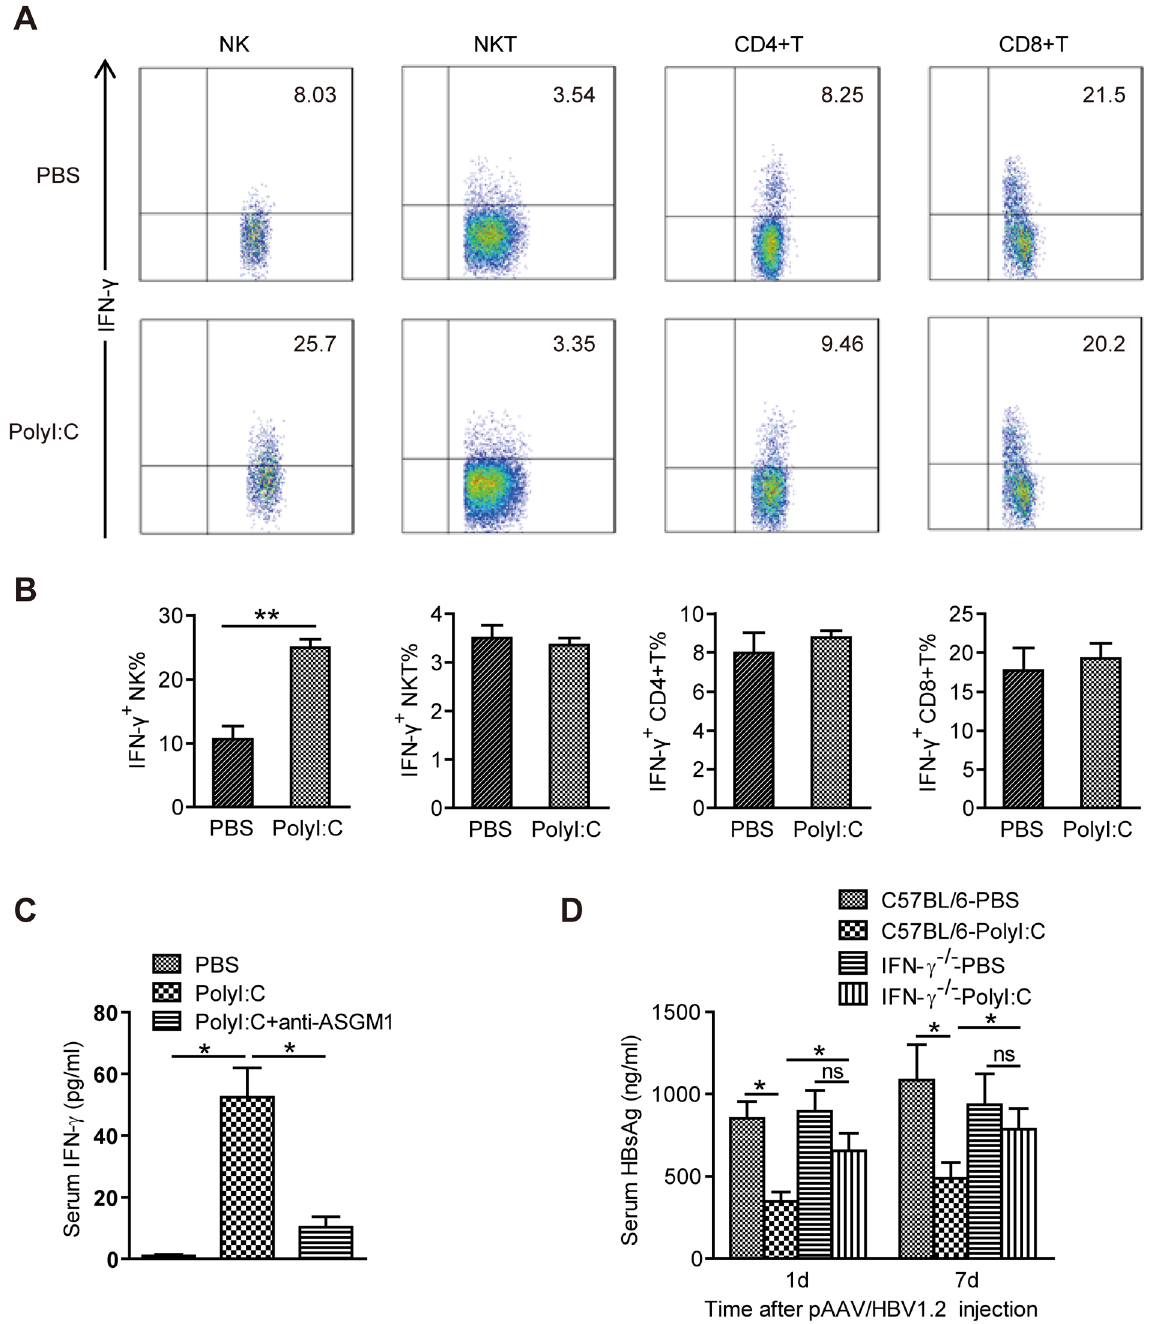
Figure 6. Anti-HBV activity of PolyI:C is dependent on NK cell-derived IFN- γβ . ( A , B ) C57BL/6 mice were injected with HBV plasmid and chronically treated with Poly I:C as described in Materials and Methods. Intracellular cytokine staining was performed to examine IFN- γ production from NK cells (CD3-NK1.1 + ) at 6 days after pAAV/HBV1.2 injection. ( C ) Mice were injected with HBV plasmid and chronically treated with anti–ASGM-1 Ab and Poly I:C as described in Materials and Methods. Serum levels of IFN- γ at 6 days after pAAV/HBV1.2 injection were determined by ELISA. ( D ) IFN- γ − / − mice were hydrodynamically injected with HBV plasmid and chronically treated with Poly I:C. Titers of serum HBsAg were determined at the indicated time points post injection. Data are shown as mean ± SEM; * p < 0.05, ** p < 0.01. n = 4–6 in each